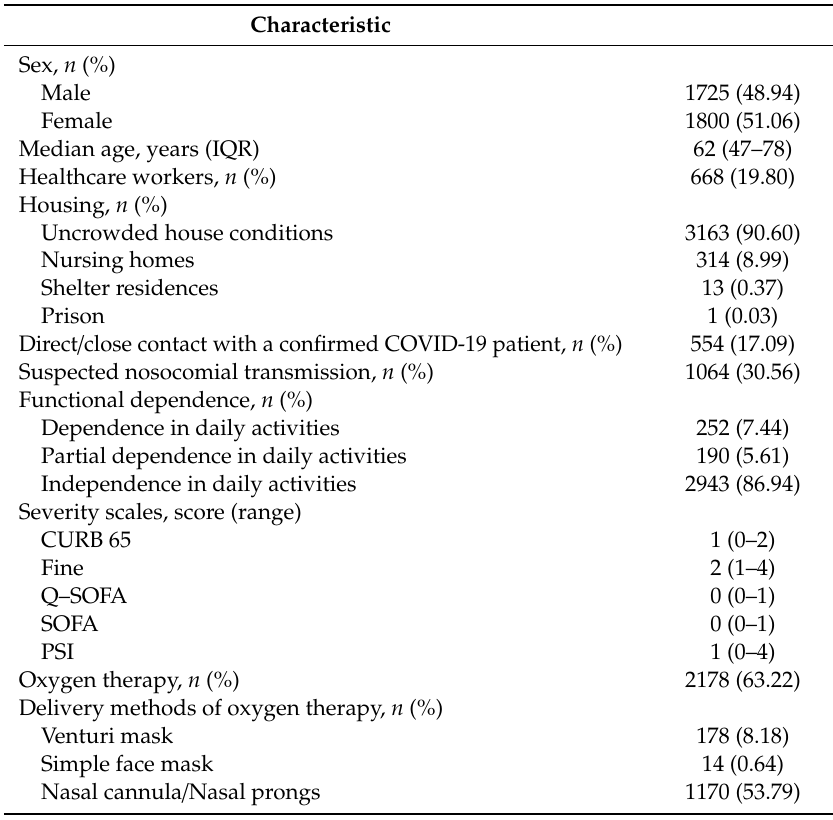
Table 1. Cohort’s Demographic